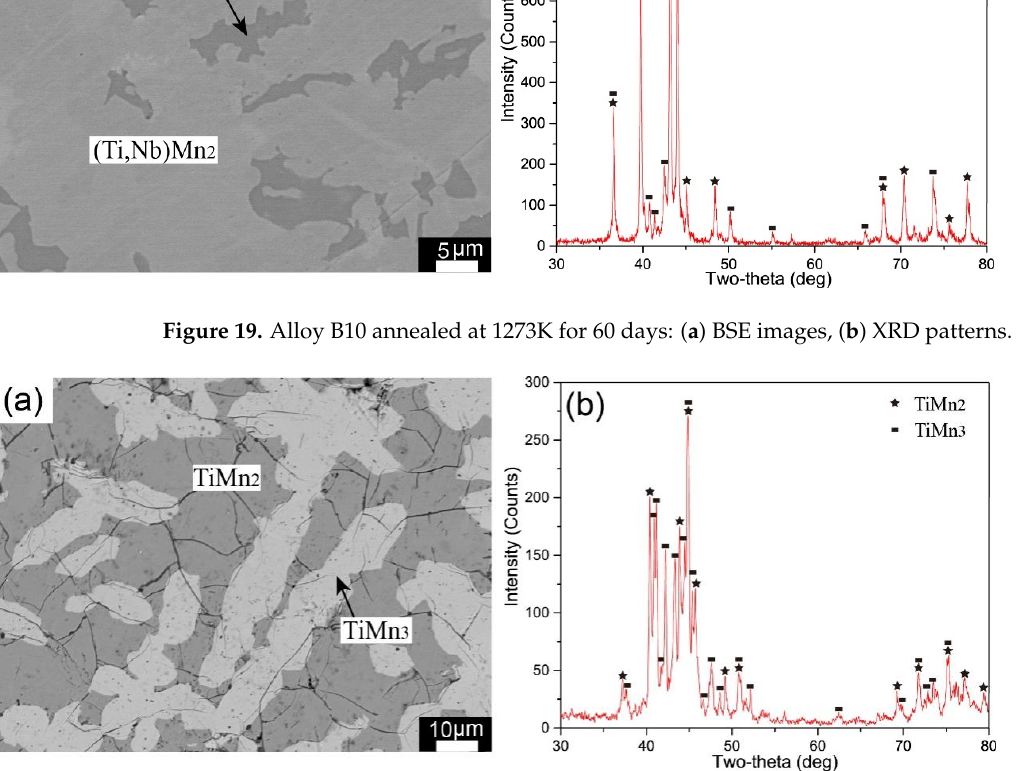
Figure 20. Alloy B16 annealed at 1273K for 60 days: ( a ) BSE images, ( b ) XRD patterns.